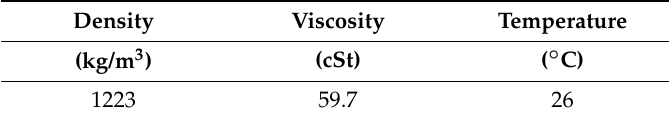
Table 2. Physical characteristics of the tested glycerol–water solution.